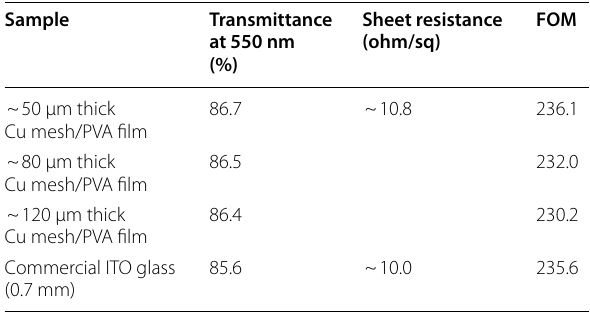
T R where are the measured sheet resistance and S and the optical transmittance at 550 nm, respectively, and Z 0 is the impedance at free space (377 Ω). As shown in the Table 1, the Cu mesh/PVA film with ~ 50 µm thick PVA substrate has an FOM value of 236.1, which is simi- lar to that of commercial ITO glass (235.6). The weights of the Cu mesh-based TCFs fabricated on ~ 50, ~ 80, and ~ 120 µm thick PVA films were measured to be 27.8, 42.7, and 65.9 mg, respectively. The weight per unit area of the Cu mesh-based TCF with ~ 50 μm PVA substrate was approximately 0.0695 mg/mm 2 . As seen in Fig. 2b, the optical and electrical conductance of the Cu mesh/ PVA film-based TCF with ~ 50 µm thick PVA substrate